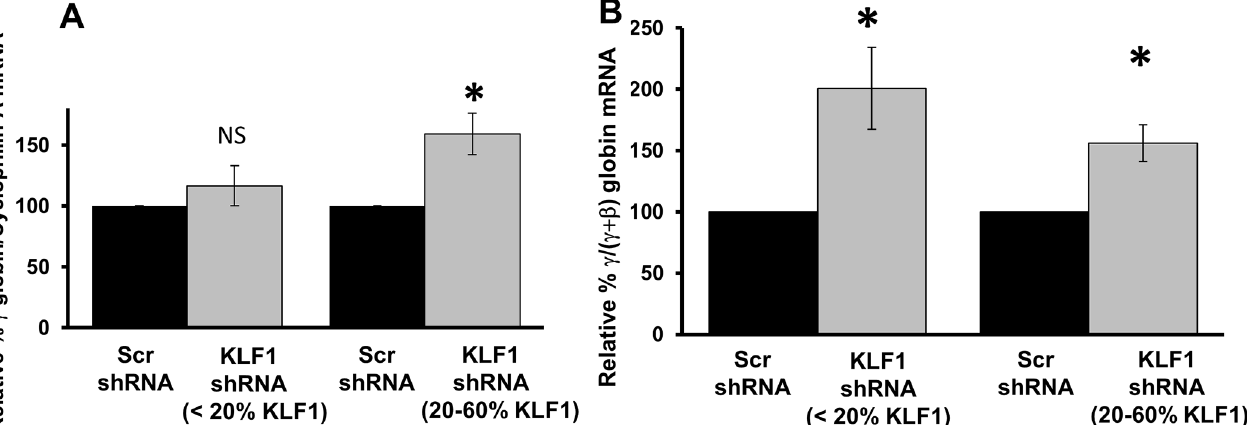
Fig 5. γ -globin mRNA amounts with modest and robust KLF1 knockdown. UCB samples were divided into two groups based on the amount of residual KLF1 mRNA after knockdown (see supplementary Fig 2B). The first group consists of samples which showed robust KLF1 knockdown ( < 20% residual KLF1; N = 10). The second group had modest knockdown of KLF1 (20 – 60% residual KLF1, N = 9). The primers for γ -globin collectively measure A γ - and G γ -globin mRNA. A) Absolute amounts of γ -globin mRNA are increased above normal only in the presence of a threshold amount of KLF1. Within each group, the fold change in γ -globin expression in KLF1 shRNA-treated cells was calculated by setting the amount of γ -globin mRNA in Scr shRNA-treated controls to 100. Cyclophilin A mRNA was used as the internal standard for qPCR. Error bars = standard error, * = p-value < 0.005, NS = not significant. (B) γ -globin is increased relative to total ( γ + β )-globin with any amount of KLF1 knockdown. The amount of γ -globin mRNA in Scr and KLF1 shRNA-treated cells was measured by qRT-PCR and reported as a fraction of total ( γ + β )-globin mRNA. In each group the fold change in γ -globin expression in KLF1 shRNA-treated cells was calculated by setting the amount of γ -globin in Scr shRNA-treated controls to 100. Error bars = standard error, * = p-value <